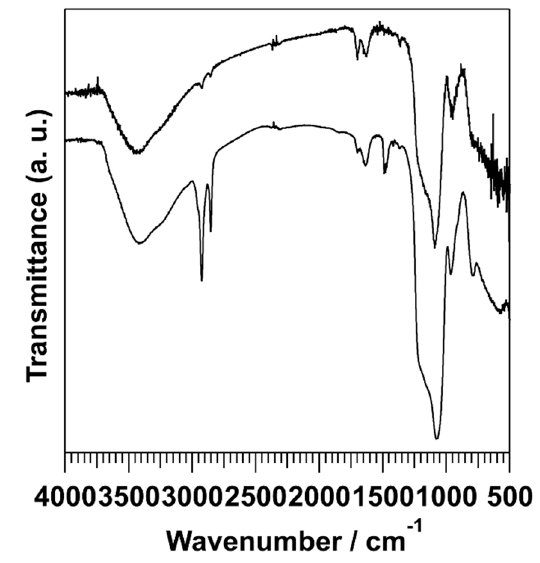
Figure 6. IR spectra of ASP–P25 mixed solid ( bottom ) and Cu–P25–ASP ( top ).